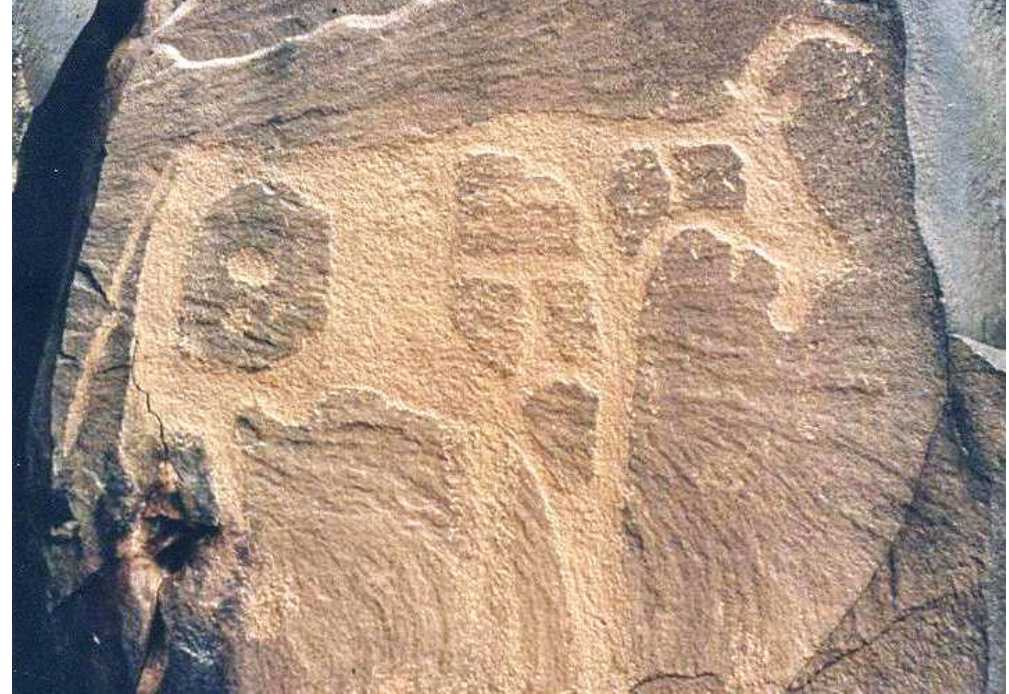
Figure 3. Example of pecked cattle group from Adrar n’Metgourine, west of Tata, south Morocco.